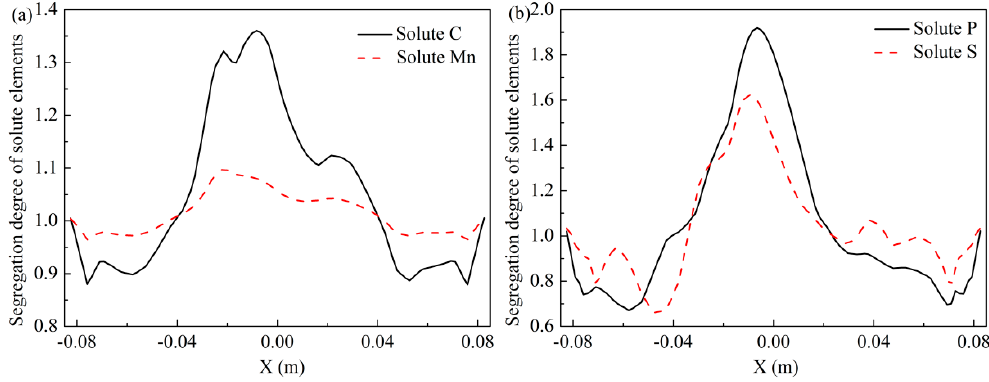
Figure 14. Comparison in the segregation profiles between different elements: ( a ) solutes C and Mn; and ( b ) solutes P and S.